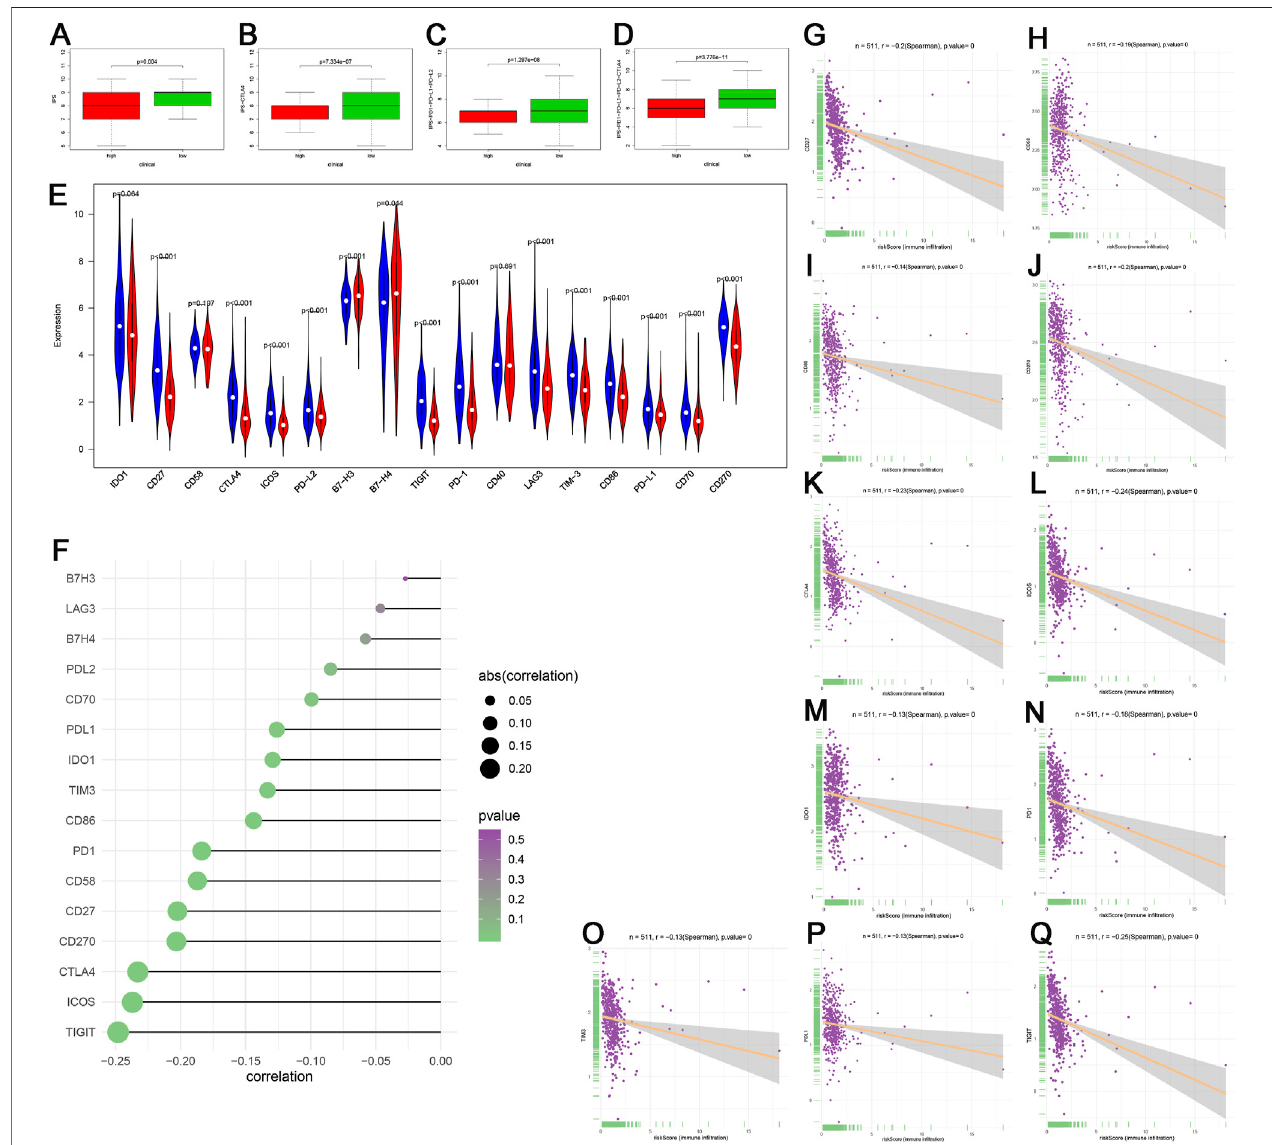
FIGURE 7 | Immunophenoscore (IPS) and gene expression analyses of immune checkpoint. (A – D) Patients in the low-risk group had higher scores of IPS, IPS- PD1-PD-L1-PD-L2, IPS-CTLA4, and IPS-PD1-PD-L1-PD-L2-CTLA4 than patients in the high-risk group. (E) Comparison of the expression of immune checkpoint between the different risk groups. (F – Q) The associations among TIGIT, ICOS, CTLA4, CD27, CD270, CD58, PD-1, CD86, TIM-3, IDO1, PD-L1, and risk score. In the high-risk group, N (cid:1) 267; in the low-risk group, N (cid:1) 244.